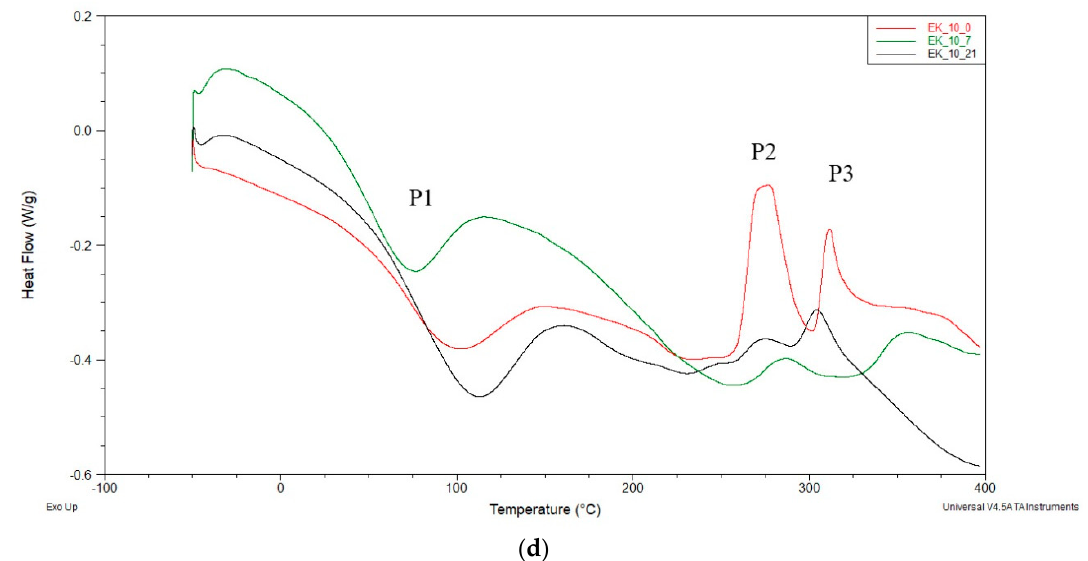
Figure 5. DSC thermograms of: ( a ) Unmodified foam (W series); ( b ) foam modified by cinnamon extract (C series); ( c ) foam modified by green coffee extract (KZ series); ( d ) foam modified by cocoa extract (EK series).